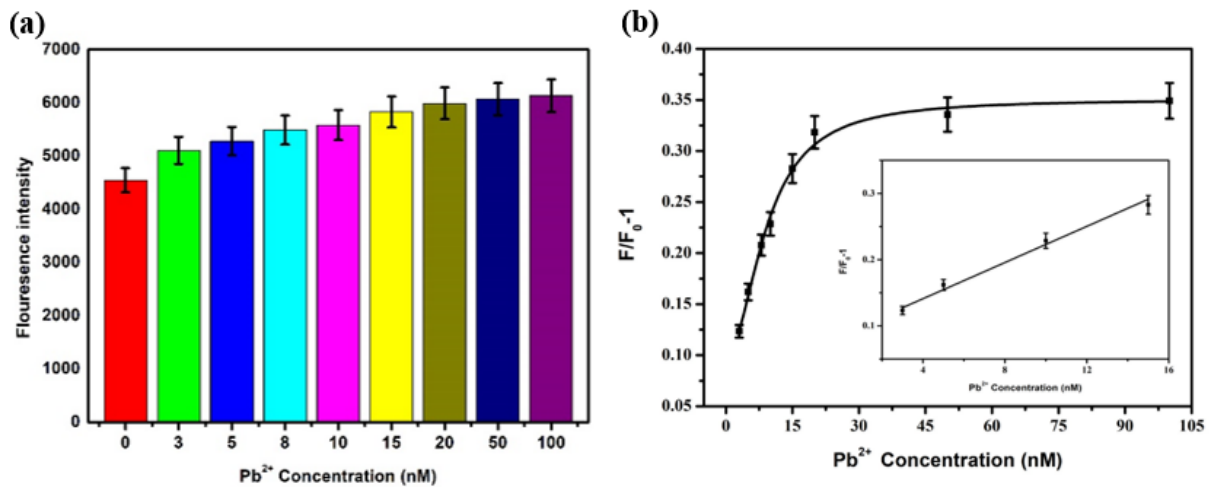
Figure 9. Under the condition of 500 nM PEG, ( a ) the fluorescence intensity and ( b ) the change of F/F 0- 1 after adding Pb 2+ with different concentrations.